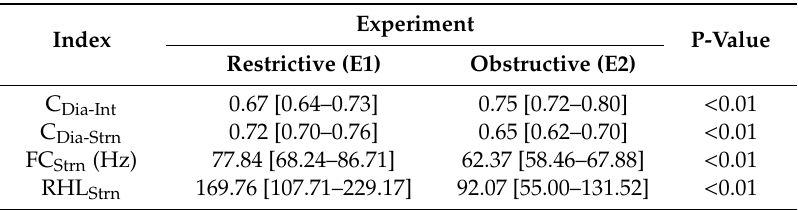
Table 3. Restrictive and obstructive breathing pattern classification. The median values and interquartile ranges of each index are shown.